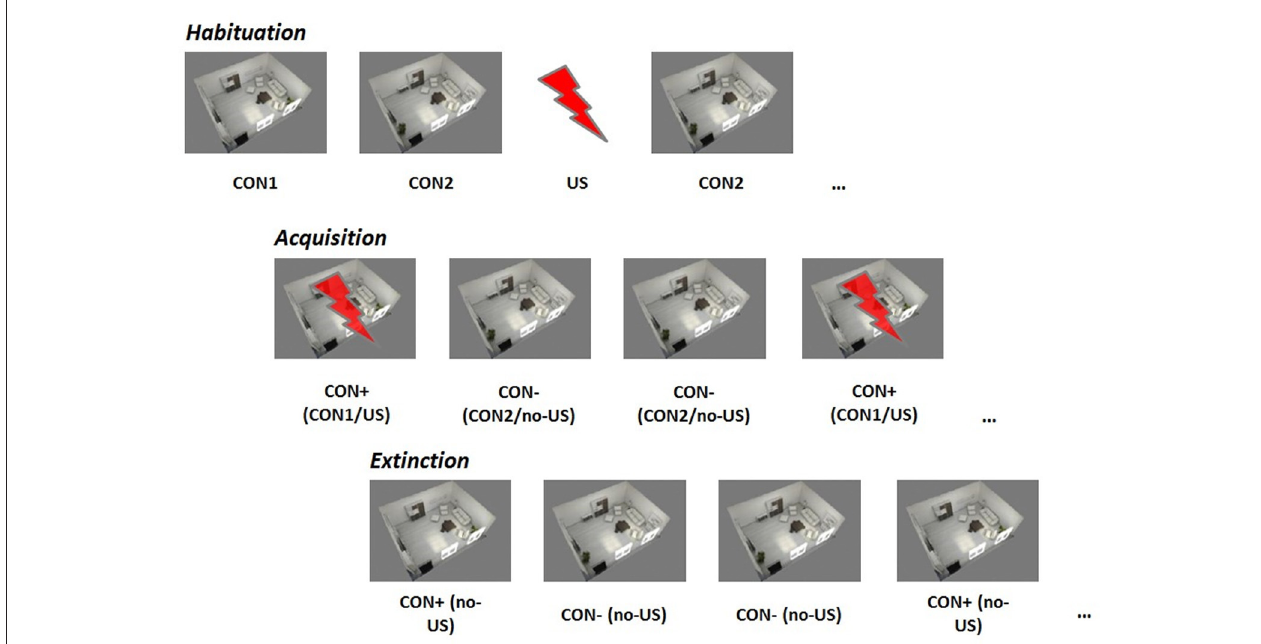
FIGURE 1 | Contextual fear conditioning paradigm. CON1/ + , conditioned stimulus paired with the unconditioned stimulus; CON2/ − , conditioned stimulus never paired with the unconditioned stimulus, US, unconditioned